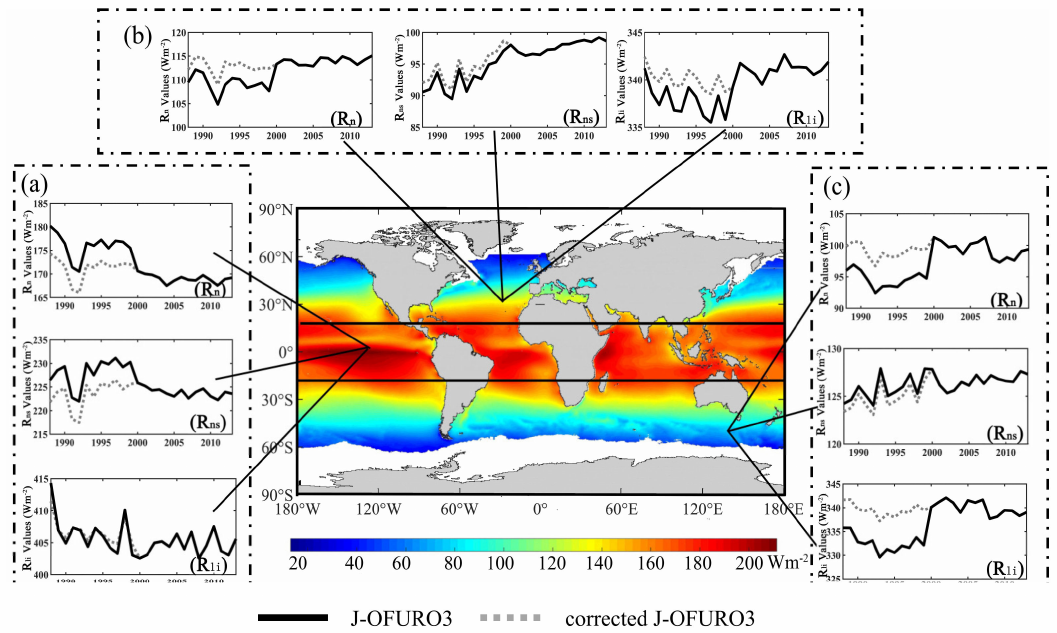
Figure 11. Interannual variations in the average annual mean sea-surface R n , R ns , and R 𝑙𝑖 for three regions: ( a ) 20°S – 20°N, ( b ) north of 20°N, and ( c ) south of 20°S from 1988 to 2013 for J-OFURO3 and corrected J-OFURO3, respectively.